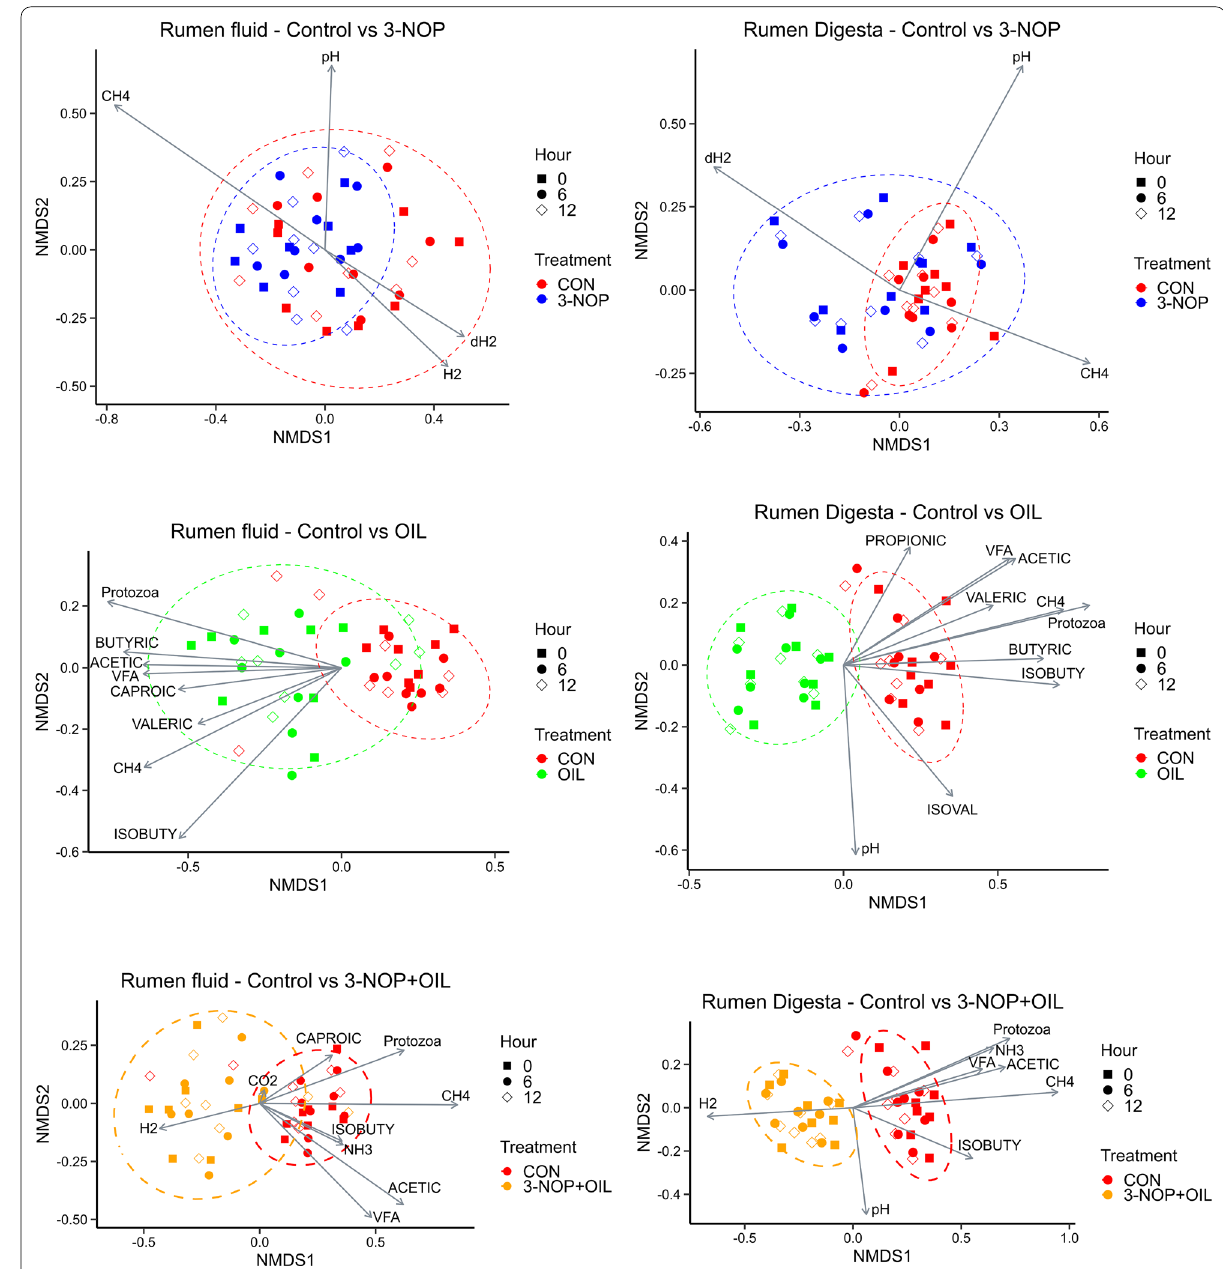
Fig. 4 Impact of 3-NOP, OIL, and 3-NOP OIL on the bacterial and archaeal community in rumen digesta and rumen fluid. Non-metric + multidimensional scaling (NMDS) of the Bray–Curtis dissimilarity is shown to compare the samples as a function treatment and time. Vectors having a statistically significant association ( P < 0.05) with the ordinations are included. Vector length is proportional to the degree of correlation between the environmental parameter and the ordination. Vector abbreviations: H 2 , CO 2 , CH 4 emissions adjusted for dry matter intake. dH 2 : dissolved hydrogen, ISOBUTY: isobutyric acid, ISOVAL: isovaleric acid, VFA: total VFA